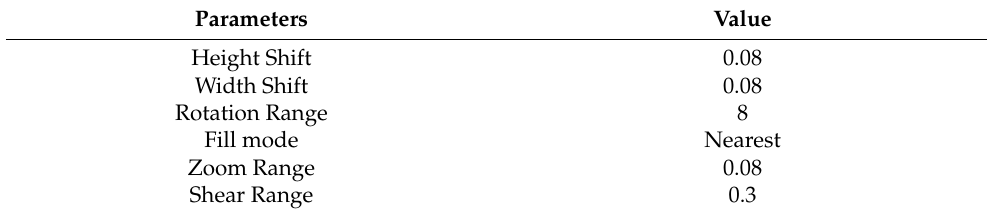
Table 1. Image augmentation setting parameters applied to original NEU